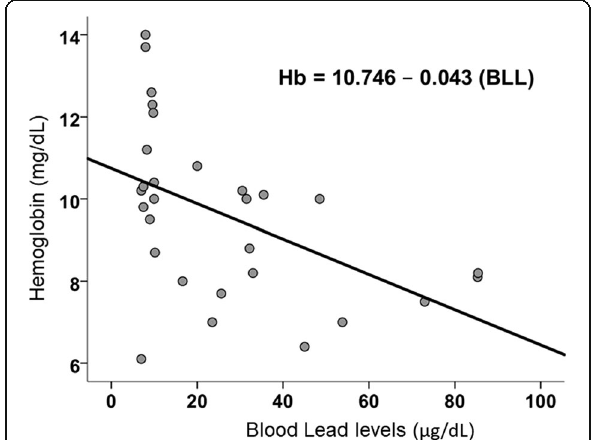
Fig. 1 Correlation plot showing the relationship between blood lead levels and